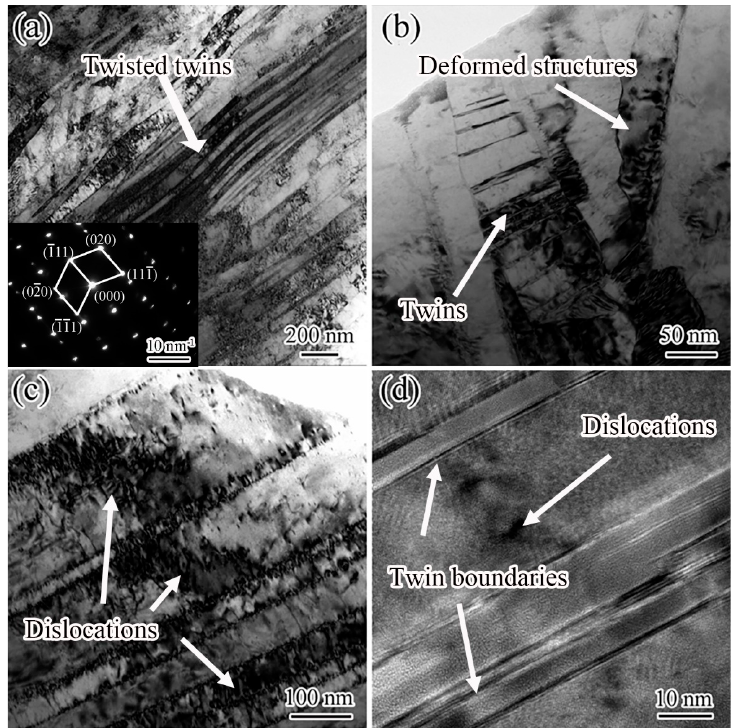
Figure 4. TEM images of CR CuNiSi alloys: ( a ) twisted twins, ( b ) elongated grains, ( c ) dislocations and ( d ) HRTEM of twins.